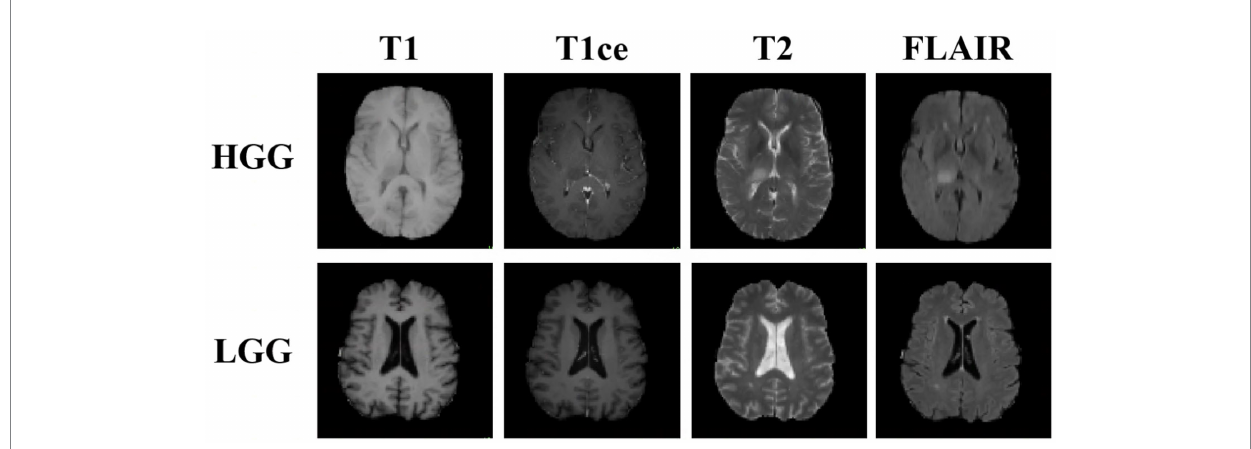
FIGURE 1 Examples of three-dimensional brain MR images of low-grade glioma (LGG) and high-grade glioma (HGG) samples. Each sample has images from four modalities: T1-weighted MRI, contrast-enhanced T1-weighted (T1ce) MRI, T2-weighted MRI, and fluid attenuation inversion recovery (FLAIR) MRI. These sequences provide complementary information for different subregions of brain